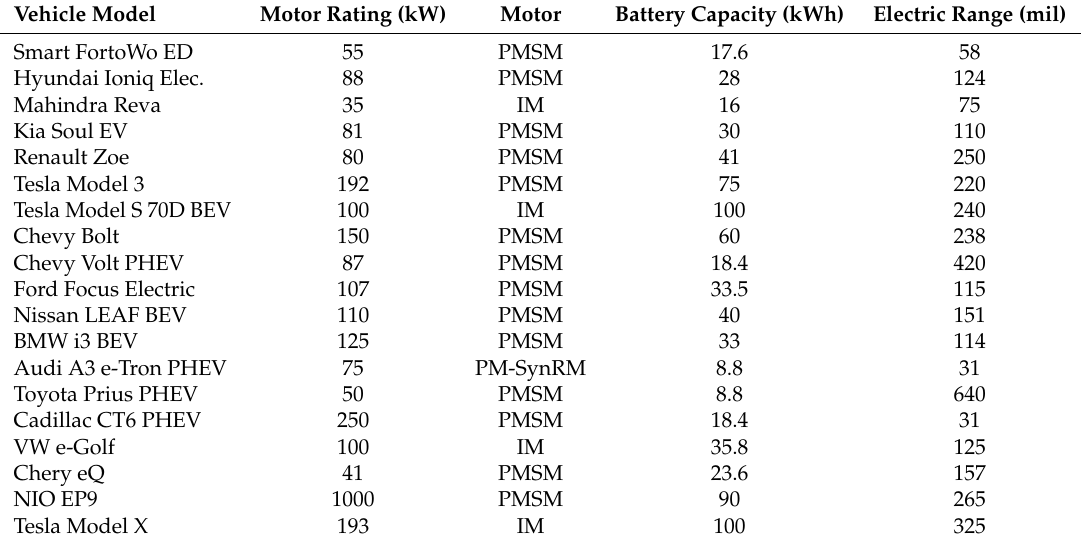
Table 1. Specifications of Commercially Available